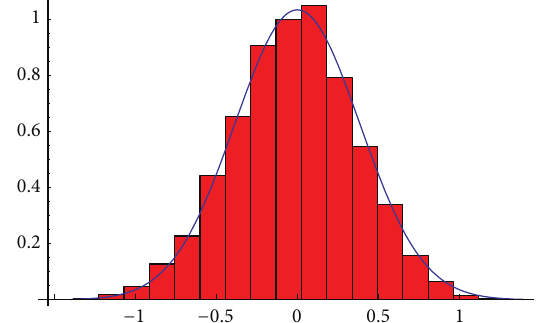
Figure 5: Histogram of the rescaled final proportion of infected individuals from 10000 simulations of the epidemic model in a population of size 1000 with mutation rate ] = 0.2 and limiting normal density